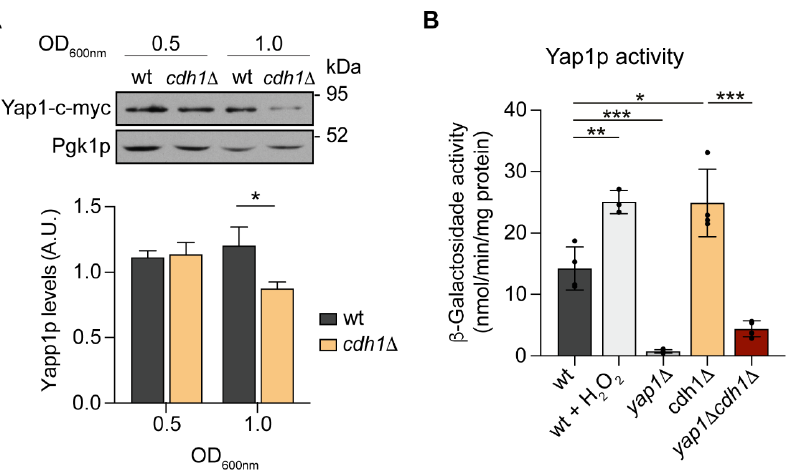
Figure 6. CDH1 deletion leads to Yap1p activation. ( A ) yap1 Δ and yap1 Δ cdh1 Δ cells harboring pRS315-Yap1-c-Myc plasmid were grown to early- and mid-log phase and total protein extracts were separated by SDS-PAGE and analyzed by immunoblotting using anti-c-myc and anti-Pgk1p. A representative blot is shown. Graph represents the relative amount of Yap1-c-myc normalized to Pgk1p. Values are the mean ± SEM ( n = 4); *, p < 0.05; t -test. ( B ) Cells with the indicated genotypes harboring pRS415-AP-1-CYC1-LacZ reporter were grown to mid-log phase. As a positive control, wt cells were exposed to hydrogen peroxide (H 2 O 2 ). The specific β -galactosidase activity was determined using o-nitrophenyl- β -d-galactopyranoside (ONPG) as a substrate. The values are the mean ± SD ( n = 4), *, p < 0.05; **, p < 0.01; ***, p < 0.001; t -test.